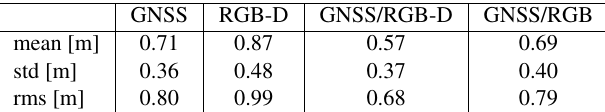
Table 1. Statistics of the differences between the estimated trajectories with respect to the reference one, see also Figure